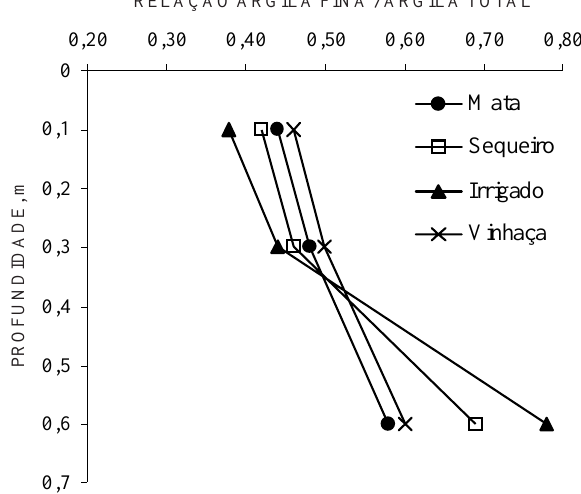
Figura 2. Distribuição em profundidade da relação argila fina/argila total nos sistemas de uso e manejo